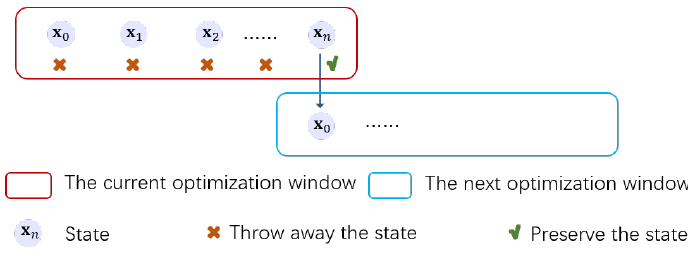
Figure 3. Illustration of the sliding window during the proposed LC optimization.